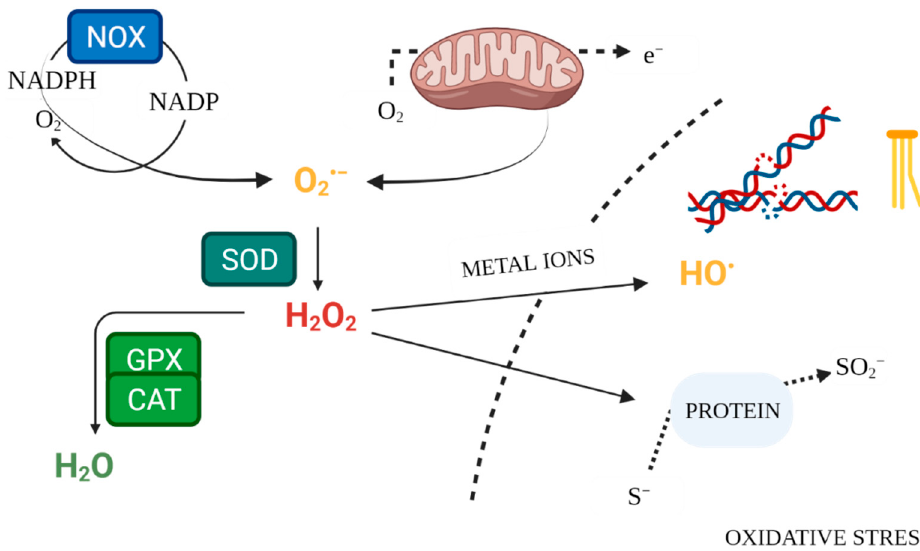
Figure 2. Free Radical Physiology. Created with BioRender.com. (accessed on 26 July 2021).